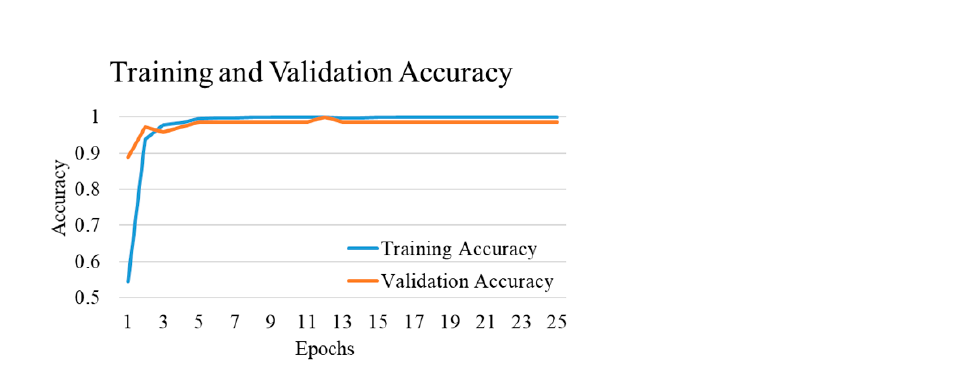
Figure 26. Training and validation accuracy of best performing VGG16 model for Faces95 images.